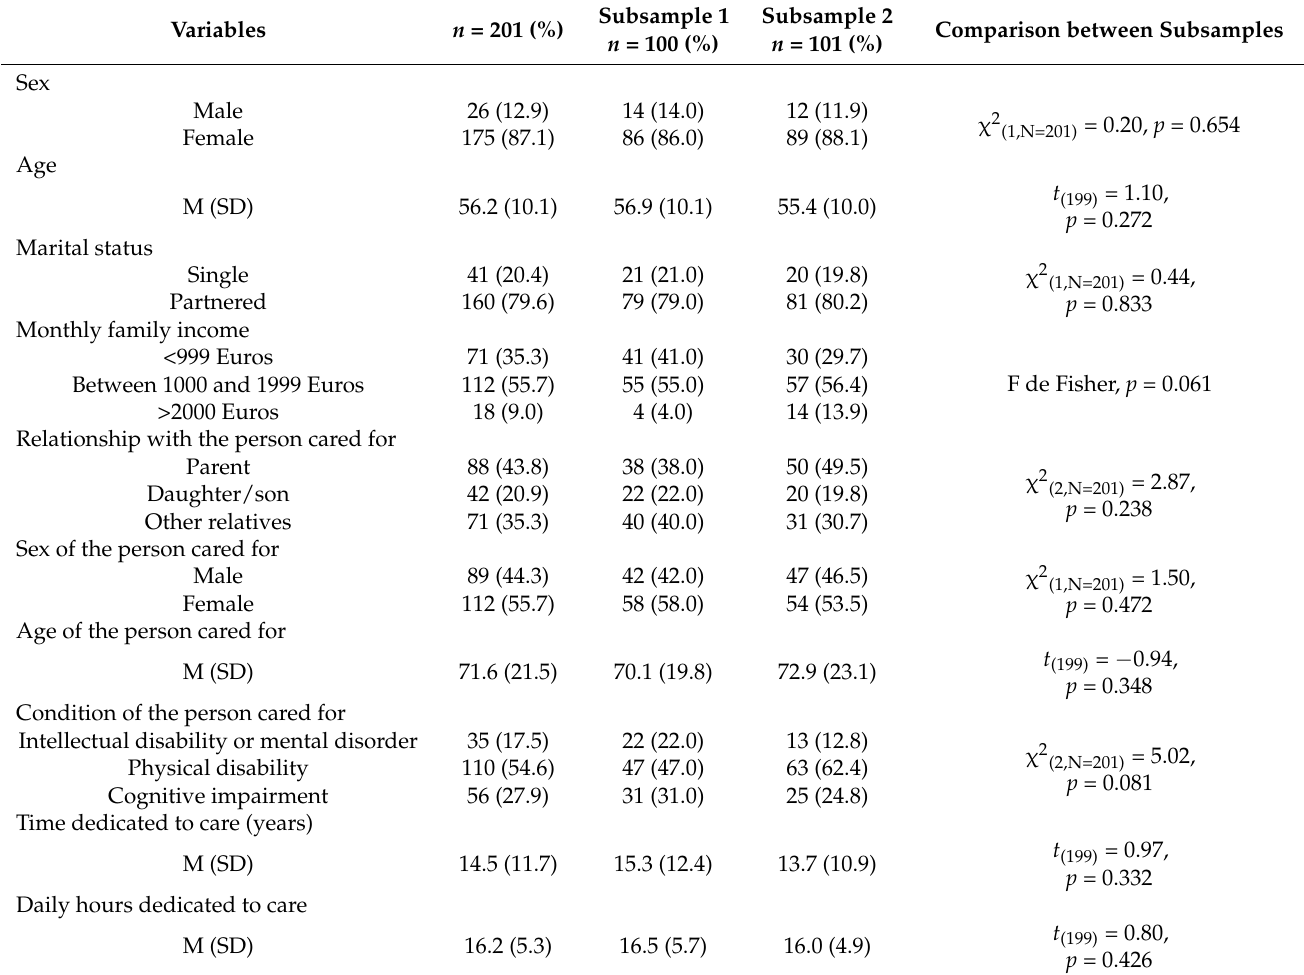
Table 1. Participants’ sociodemographic and care